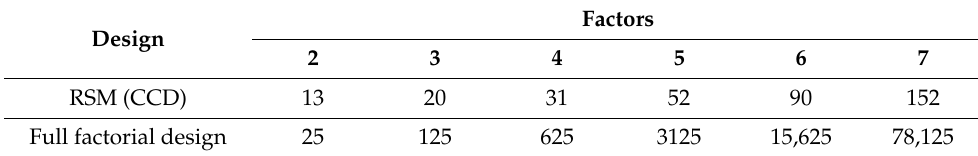
Table 1. Total number of experimental runs for full factorial design and RSM based on 5-level factors. Design